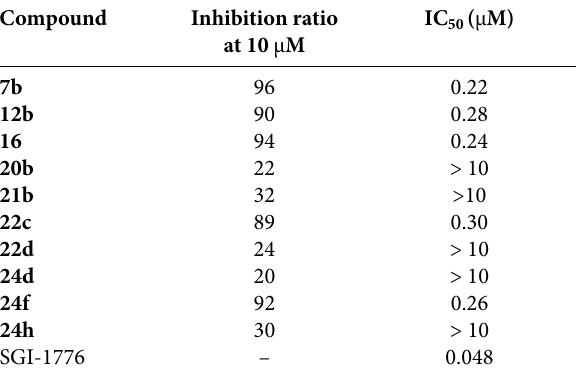
Table 4. The inhibitor activity of compounds 7b , 12b , 16 , 20b , 21b , 22c , 22d , 24d , 24f and 24h toward Pim-1 Kinase.